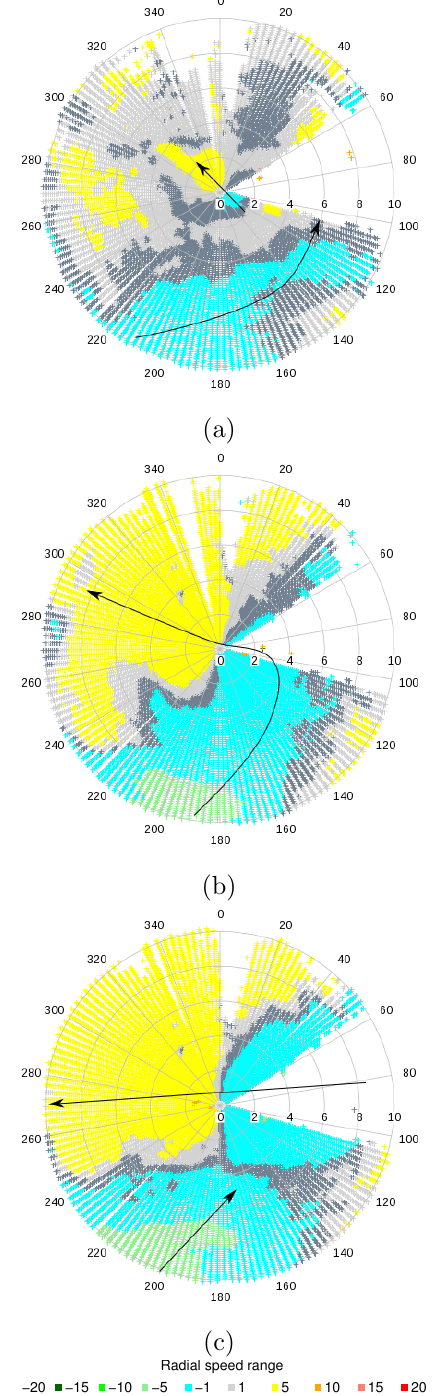
Fig. 10. 2 ◦ elevation wind lidar scans at 08:00 (a) , 08:30 (b) , 09:30 (c) and 10:00 UTC (d) on 27 March. Warm colors mean a radial wind (ms − 1 ) going away from the lidar contrary to cold colors, which represent a wind coming to the lidar. Arrows indicate a wind direction